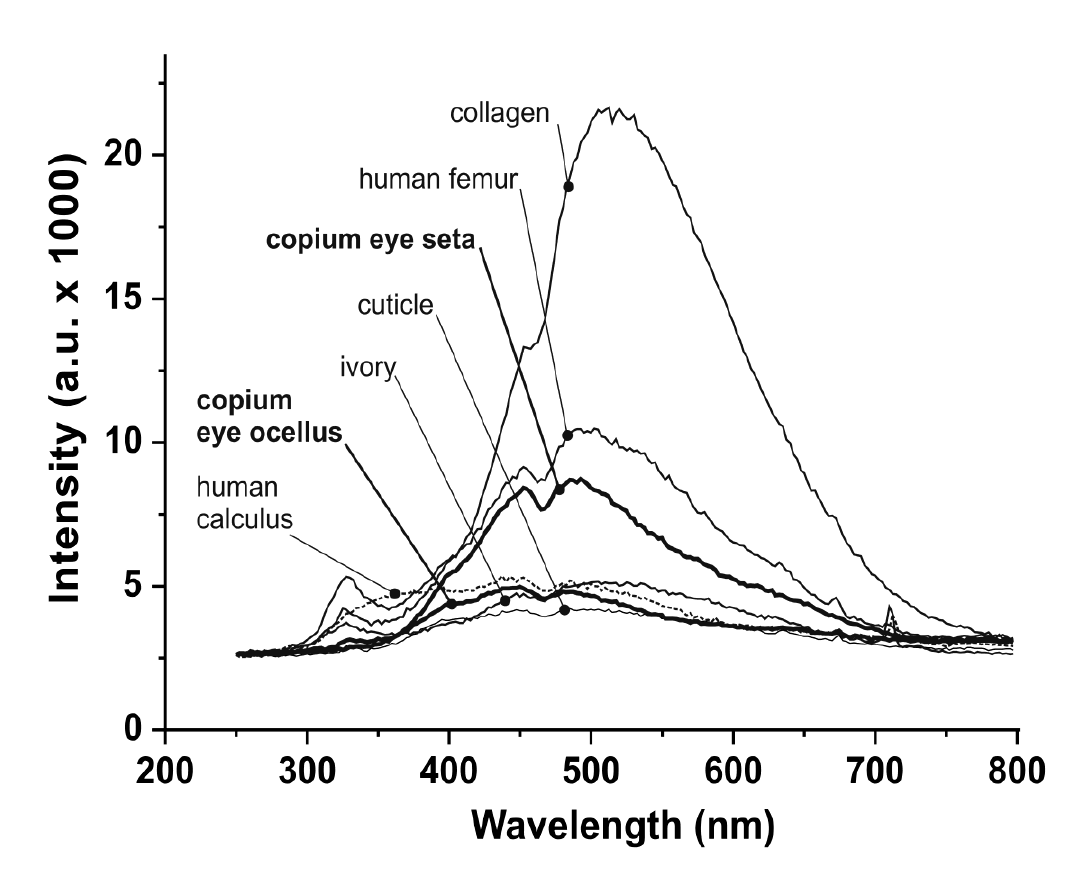
FIGURE 6. Spectra CL curves of collagen-calcium-phosphate bond materials, including Copium eye seta, ommatidium, and cuticle, together with other comparative patterns of chemical collagen, medieval human femur, Siberian mammoth ivory, and human